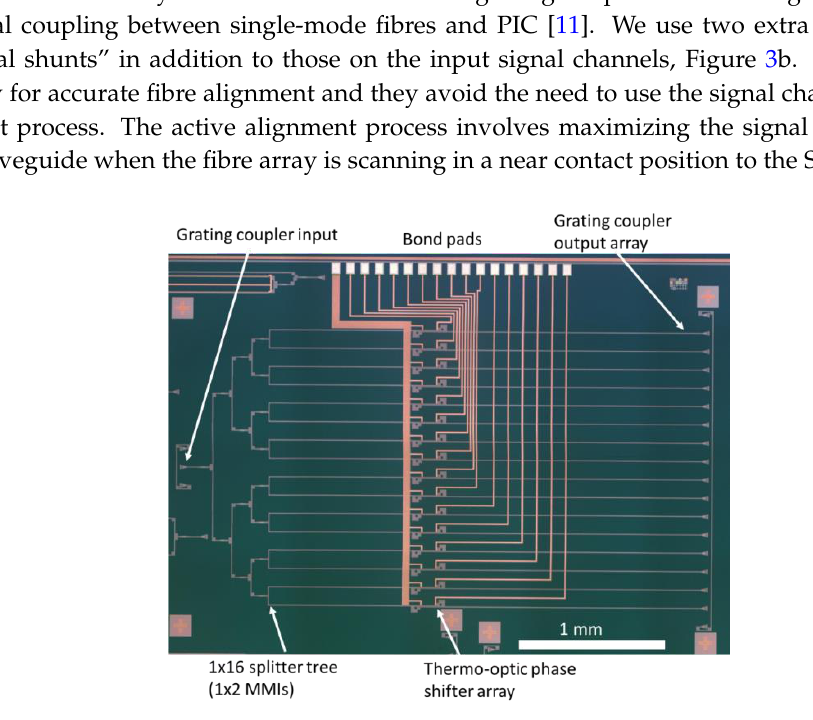
Figure 2. Microscope image of the demonstrator circuit after finalizing the silicon Photonic Integrated Circuit (PIC) fabrication process.